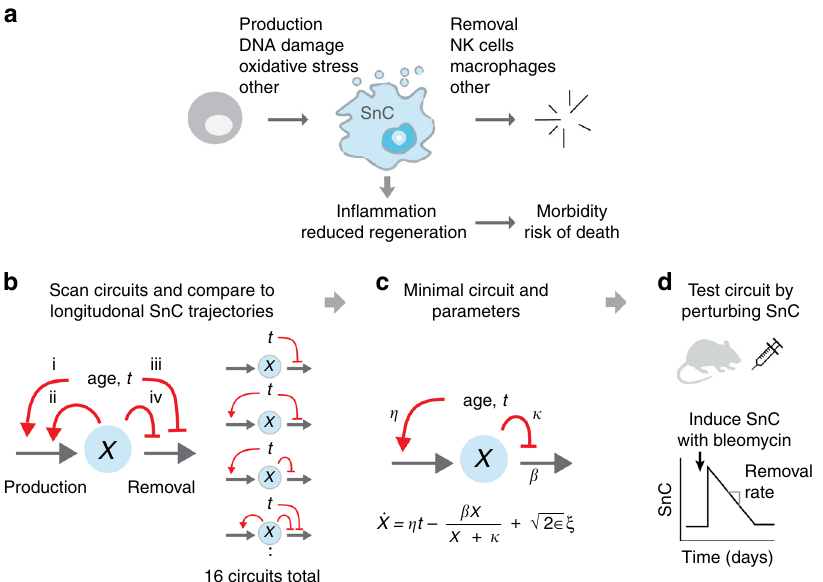
Fig. 1 Approach for inferring SnC dynamics throughout adulthood. a Many processes, including DNA damage and developmental and paracrine signals, lead to SnC production. SnCs are cleared by immune mechanisms, and secrete factors that lead to morbidity and mortality. b – d We scanned a wide class of models for SnC dynamics, and compared them to longitudinal SnC data and direct SnC perturbation experiments to establish a minimal model for SnC stochastic dynamics and determine its rate constants. In the minimal model, η is the increase in SnC production rate with age, β is the removal rate, κ is the half-way saturation point for removal, and ϵ is the noise